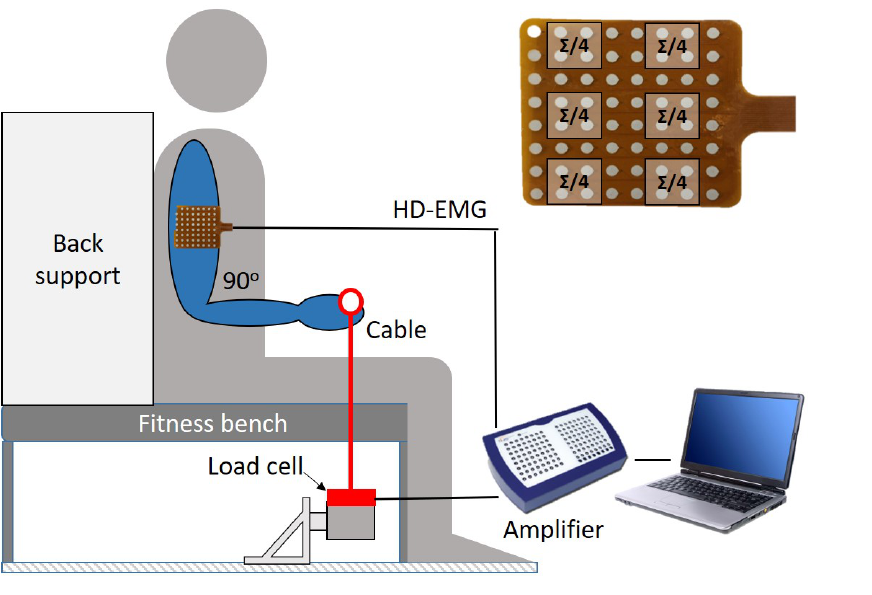
Figure 1. Schematic representation of the acquisition setup used to acquire the high-density (HD) EMG. Adapted from